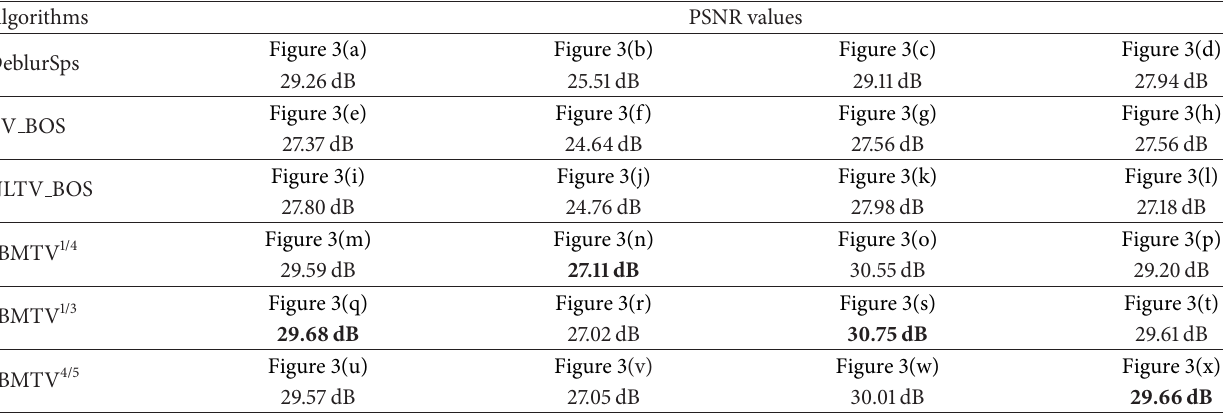
Table 3: PSNRs of images in Figure 3.